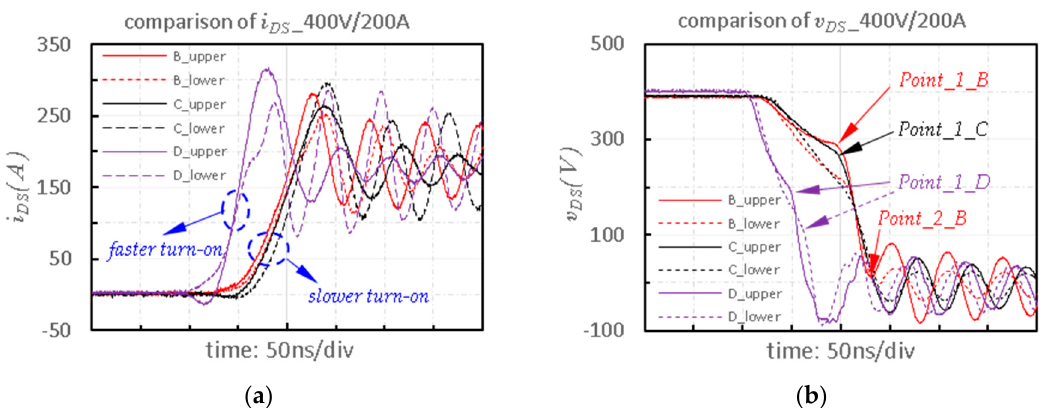
Figure 7. The turn-on transient waveforms of SiC high-power modules under condition of high V DD : ( a ) waveform of i DS , ( b ) waveform of v DS .